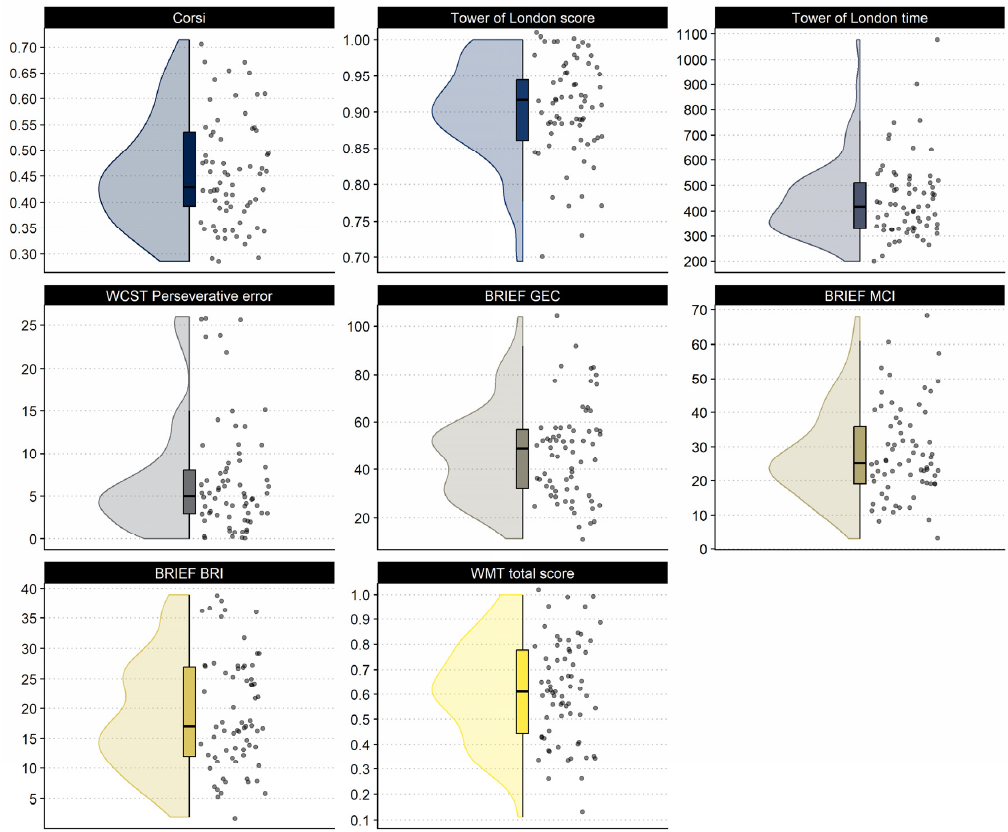
Figure 4. Raincloud plots for the behavioral variables used in Study 2. The dots indicate the given test score of each participant, and the box and violin plots present the data distribution. Note: All measures are in proportion correct of the total score, with exception of the WCST, which is the total raw number, the Tower of London Time, which is in seconds, and the BRIEF scores, which are in raw score. BRI: behavior regulation index; GEC: general executive composite; MCI: meta- cognitive index.